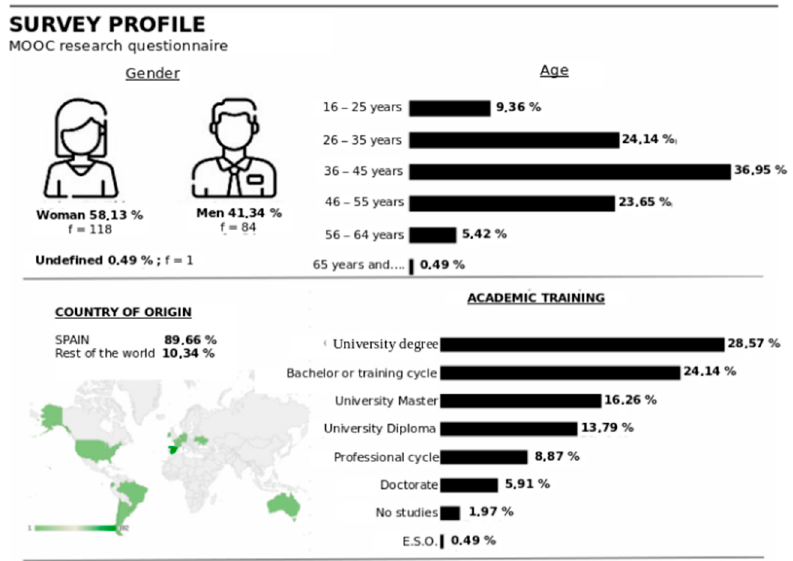
Figure 1. Respondent profile. Identification questions.